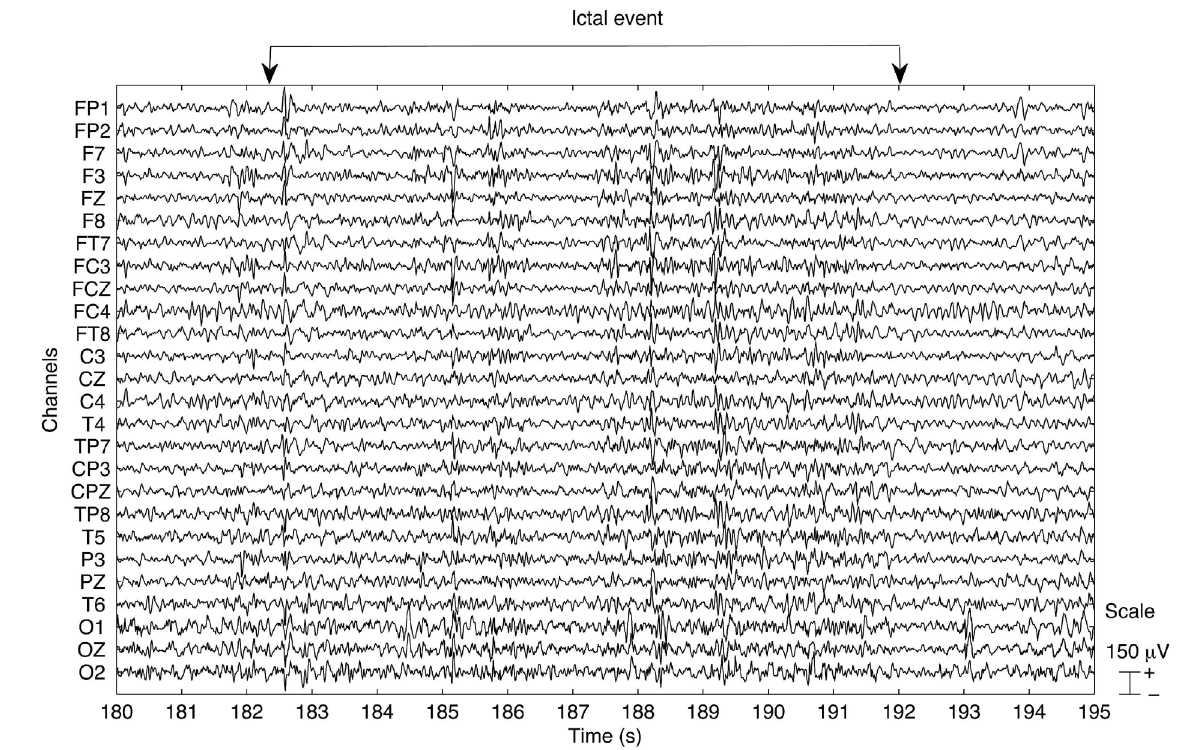
FIGURE 1 | Example of the EEG trace obtained after pre-processing the data for run 3. An ictal event occurs within the time window starting at 182s and ending at 193s, as indicated.The data appear to be clear of MR related artifacts.